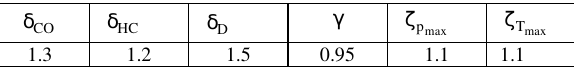
Table 3. Values of coefficients ii ,, zgd taken to definition of boundary